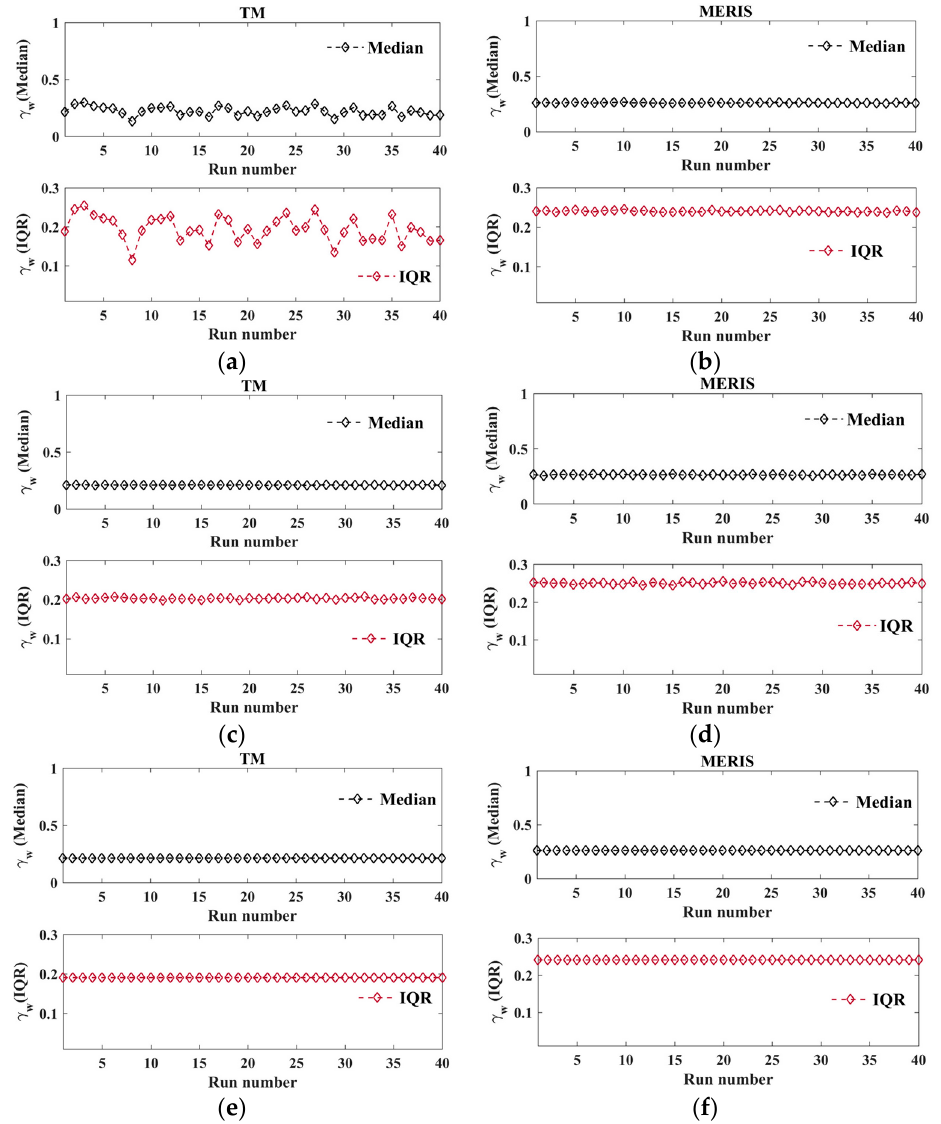
Figure 9. Medians (black diamonds) and interquartile range (IQR, red diamonds) of the γ w distributions calculated with the proposed index based spectral unmixing (IBSU) method for the Caprivi study area from TM and MERIS images on 17 April 2008 by changing randomly water ( a , b ), vegetation ( c , d ) and soil ( e , f ) endmembers.